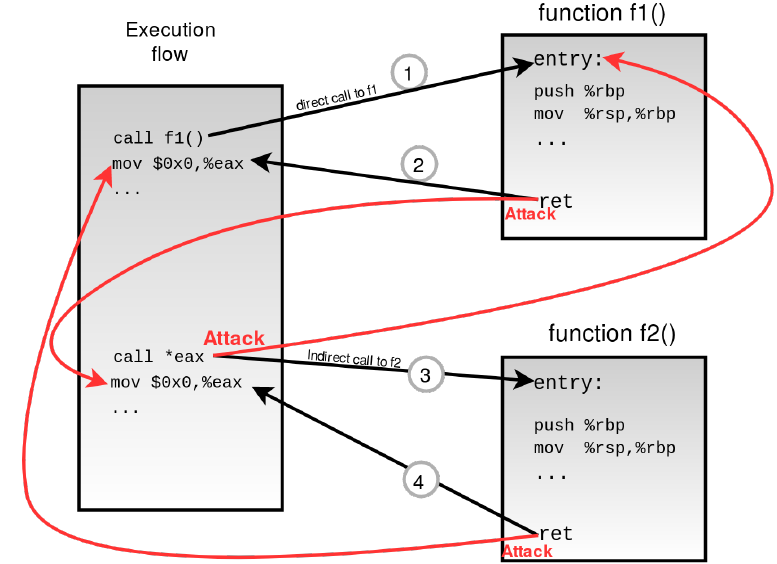
Figure 2. Coarse-grained CFI approach bypass example. The attacker is able to redirect the control flow from multiple call()s and ret points. Arrows in red show the valid destinations where attackers can redirect the